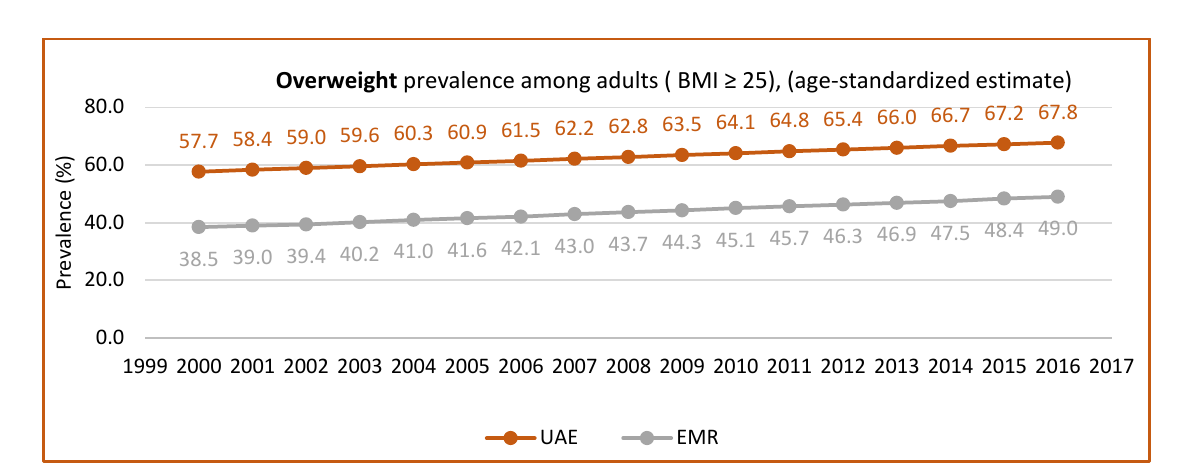
Figure 5. The prevalence of overweight in adults (BMI ≥ 25) (age-standardized estimate), the UAE trend (1999 – 2017). Source: https://www.who.int/data/gho/data, http://www.healthdata.org/results/country-profile (accessed on 5 December 2022) [33,35]. Obesity prevalence among adults ( BMI ≥ 30 ), (age-standardized estimate)